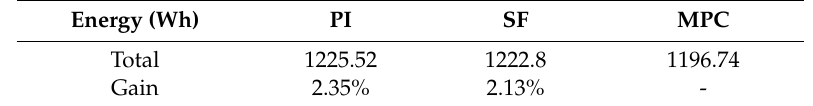
Table 3. Energy consumption based on the MPC, PI and the state feedback control